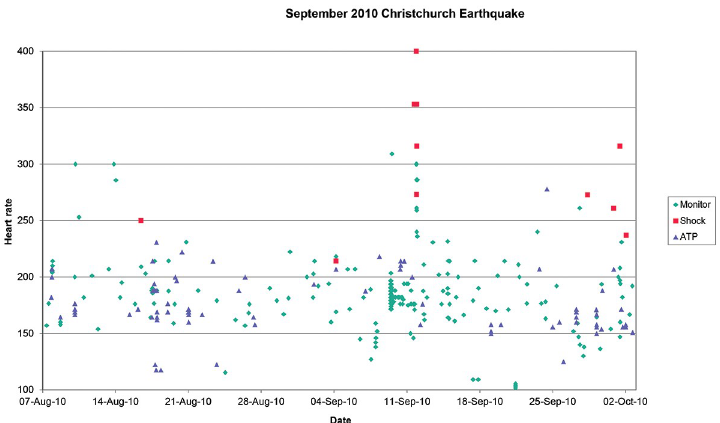
Fig 1. Ventricular arrhythmia events recorded by implantable defibrillators in 211 patients exposed to the earthquake on the 4 th September2010. Events are plotted against event heart rate. Events are classified as non- sustained (monitor), sustained treated by shock and sustained treated by antitachycardia pacing